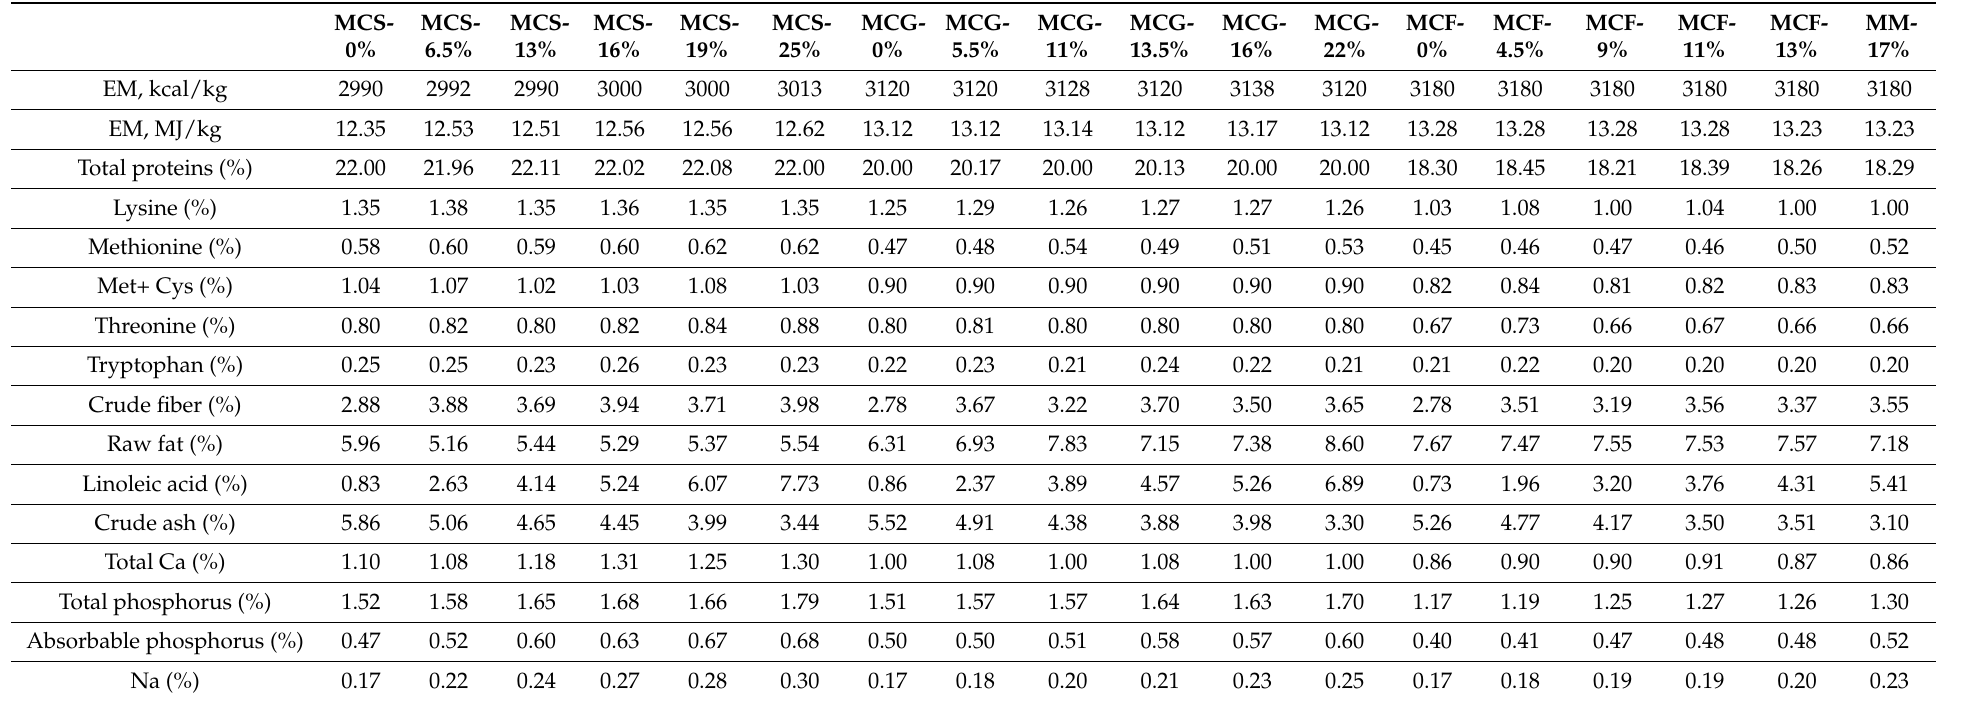
Table 5. Nutritional composition of feed compounds with and without the addition of mealworm